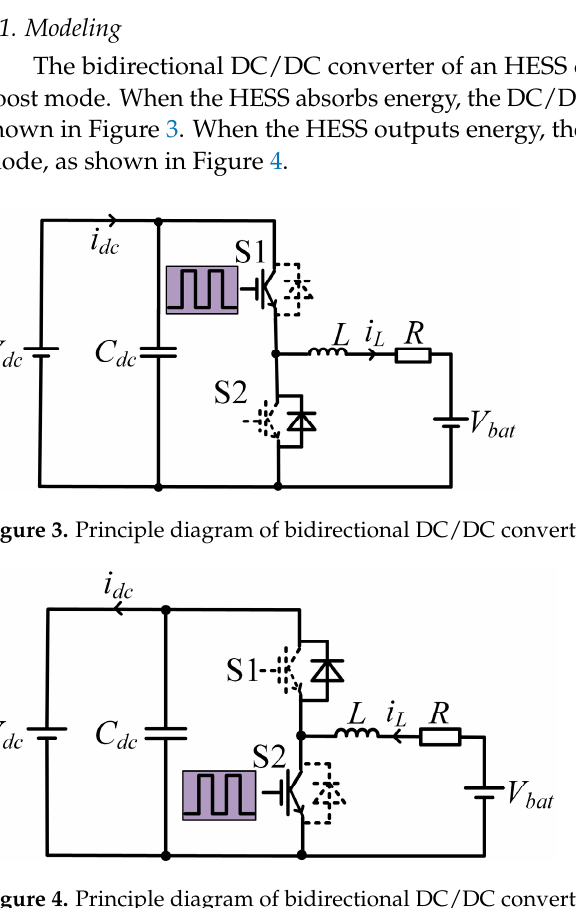
Figure 2. Simplified structure of islanded DC microgrid with HESS, CPLs and DGs.